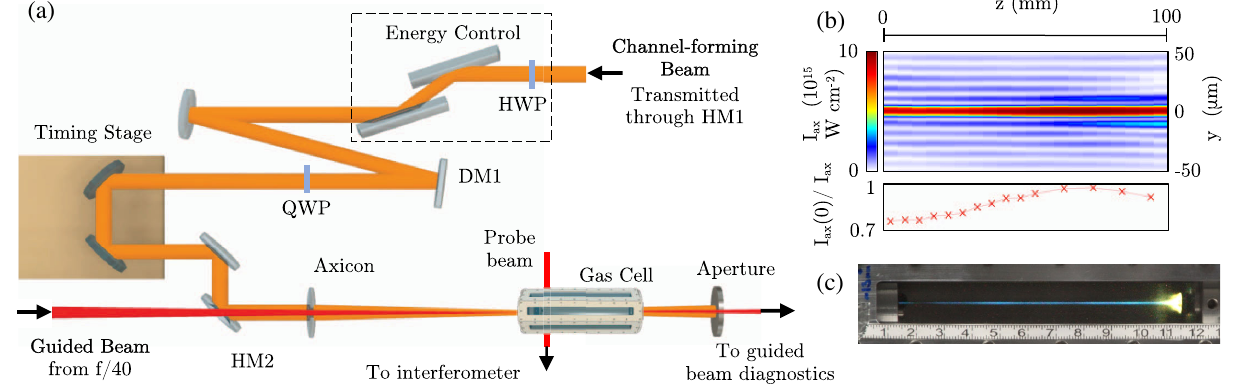
FIG. 1. (a) Schematic diagram of the experiment layout. (b) Longitudinal variation of the transverse intensity profile of the axicon focus, measured in vacuo by a camera in the vacuum chamber. The red curve shows the axial intensity I ax ð 0 Þ as a function of longitudinal position. (c) Time-integrated image of the visible plasma emission produced by the channel-forming beam focused into the gas cell at a fill pressure P ¼ 26 mbar. The scale visible at the bottom of the image is in cm. Note that the apparent decrease in plasma brightness near a scale reading of 2.5 cm arises from blackening of the cell window in that region, not from nonuniformity of the